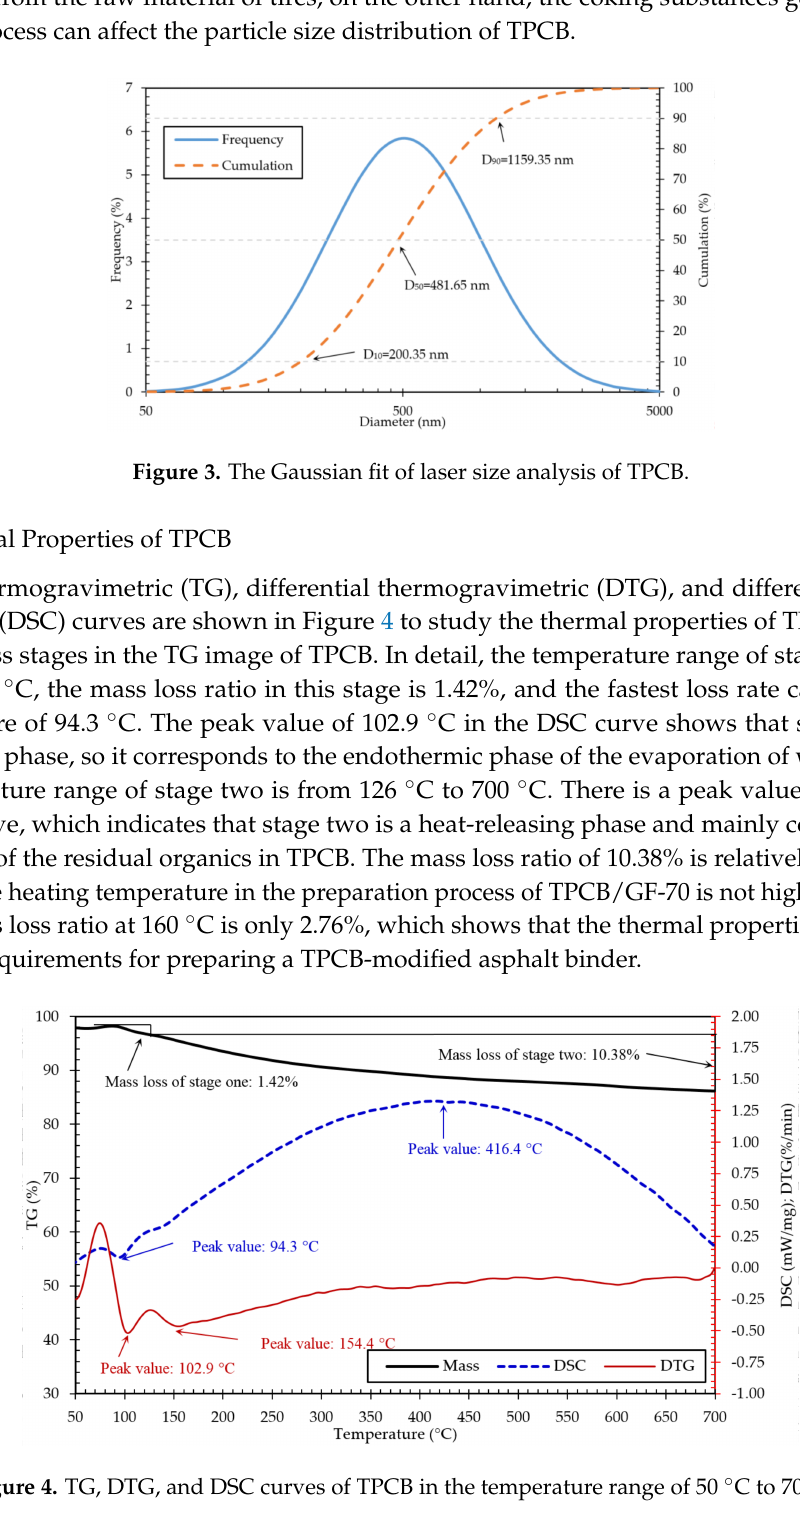
Figure 4. TG, DTG, and DSC curves of TPCB in the temperature range of 50 ◦ C to 700 ◦